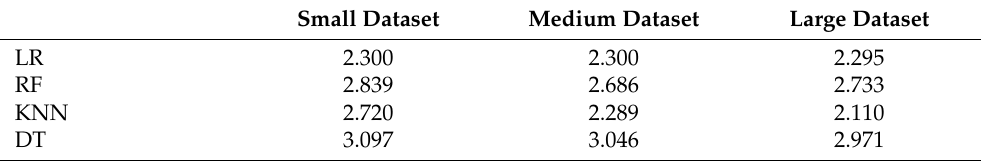
Figure 11. The MAE results for 4 localization methods using the 3 RSS datasets. Table 9. MAE results for the 4 tailored ML models using 3 different datasets.